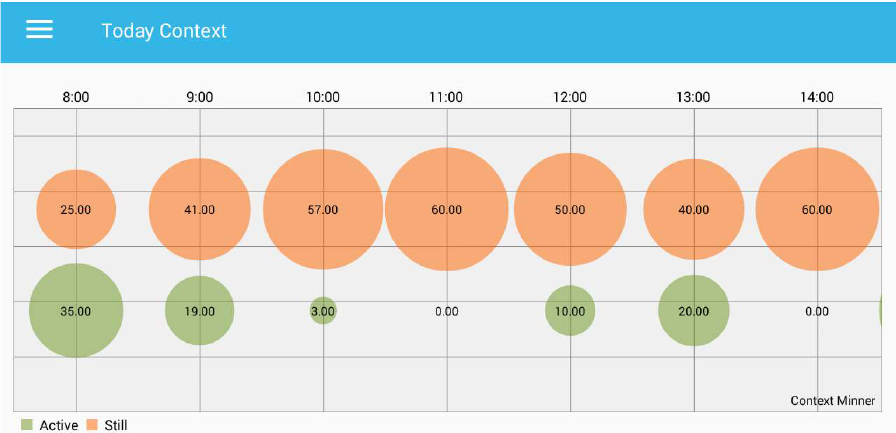
Figure 8. Hourly sedentary behaviour recognition.